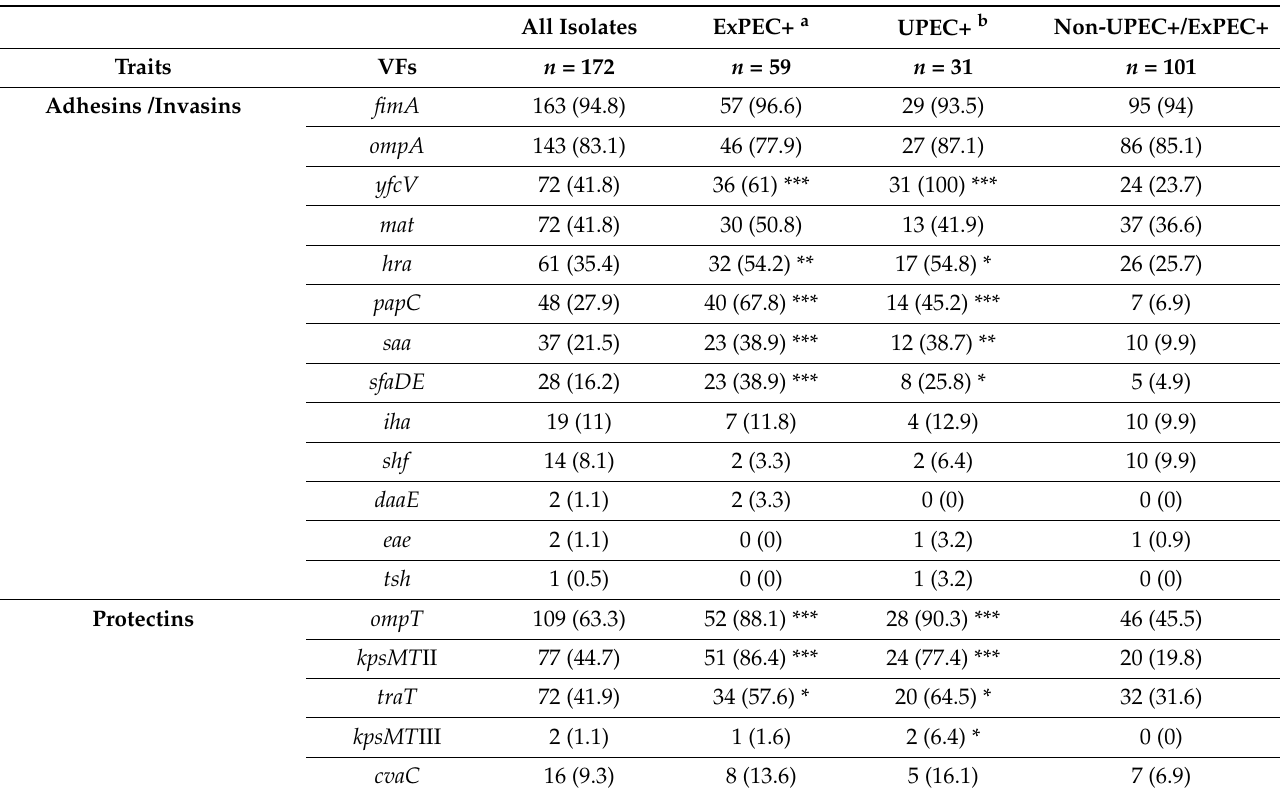
Table 2. Frequency of DEC and ExPEC virulence factors (VFs) and phylogroups of urinary tract infection strains ( n